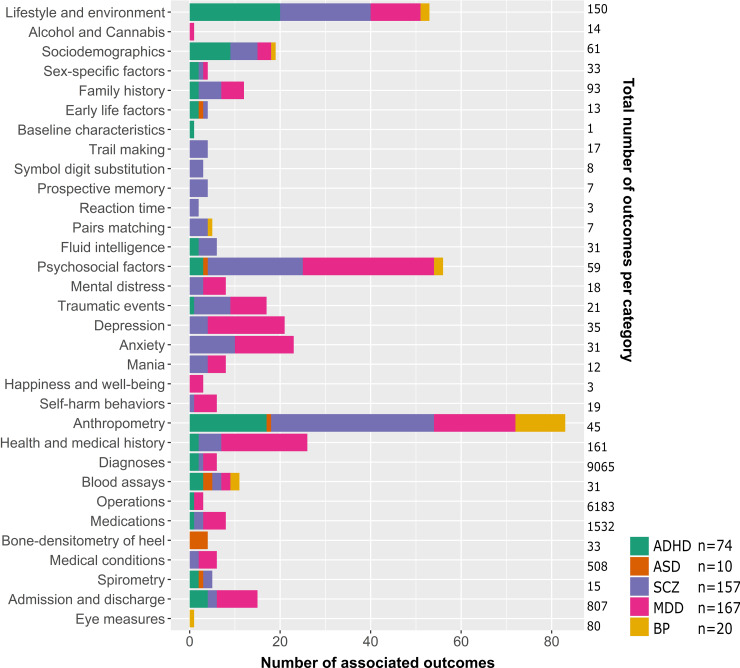
Overview of the distribution of disorder specific polygenic risk score (p<5x10-8) associated outcomes per category of the UK Biobank variables catalogue.Shown are the number of associations with polygenic risk scores for attention deficit/hyperactivity disorder (ADHD), autism spectrum disorder (ASD), schizophrenia (SCZ), major depression (MDD) and bipolar disorder (BP).